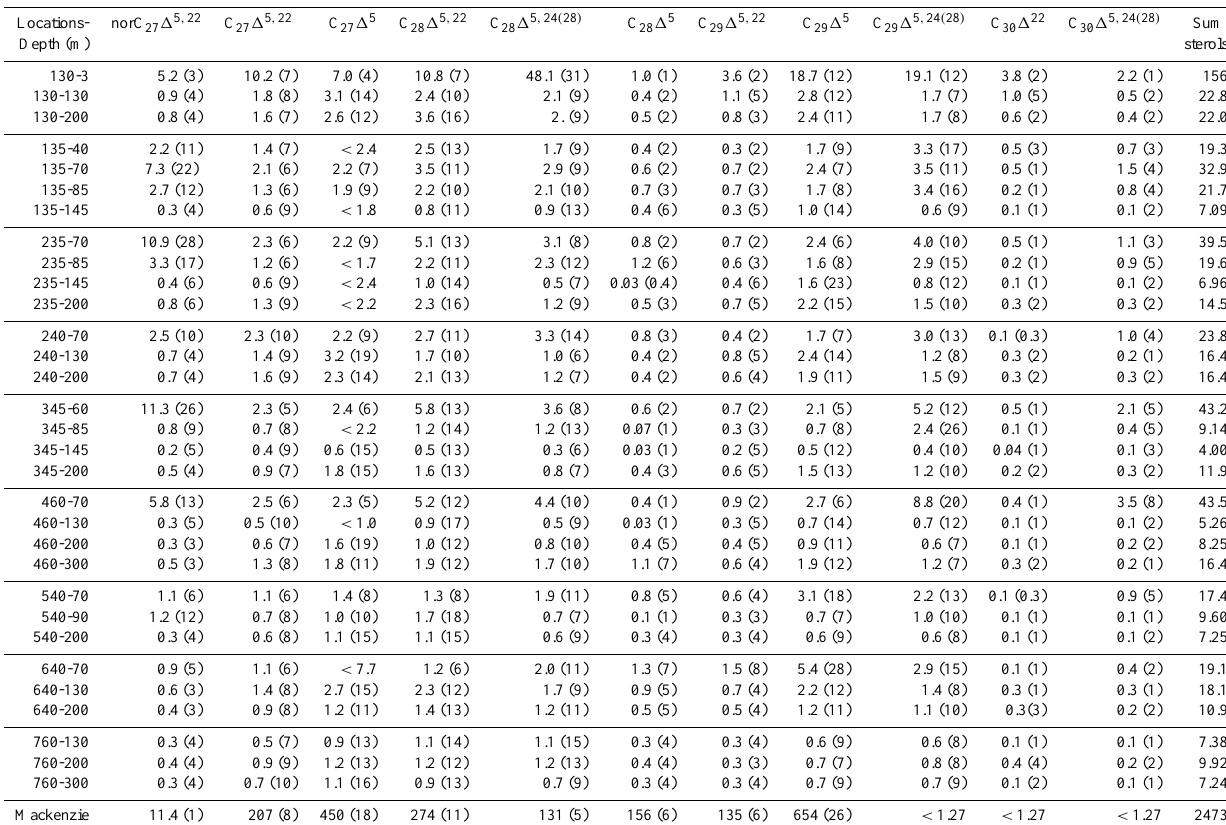
Table 7. Concentrations of sterols in suspended particulate matter (SPM) from the Beaufort Sea (ngL − 1 ). Percentage of total sterols is given in brackets.